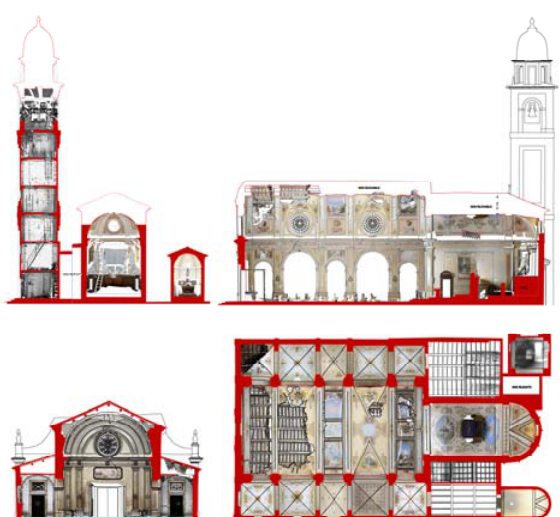
Figure 4: San Giovanni del Dosso, one of the most damaged churches. It was necessary to do a photogrammetric survey to survey not only the geometry, but also the decoration (frescoes, vaults,